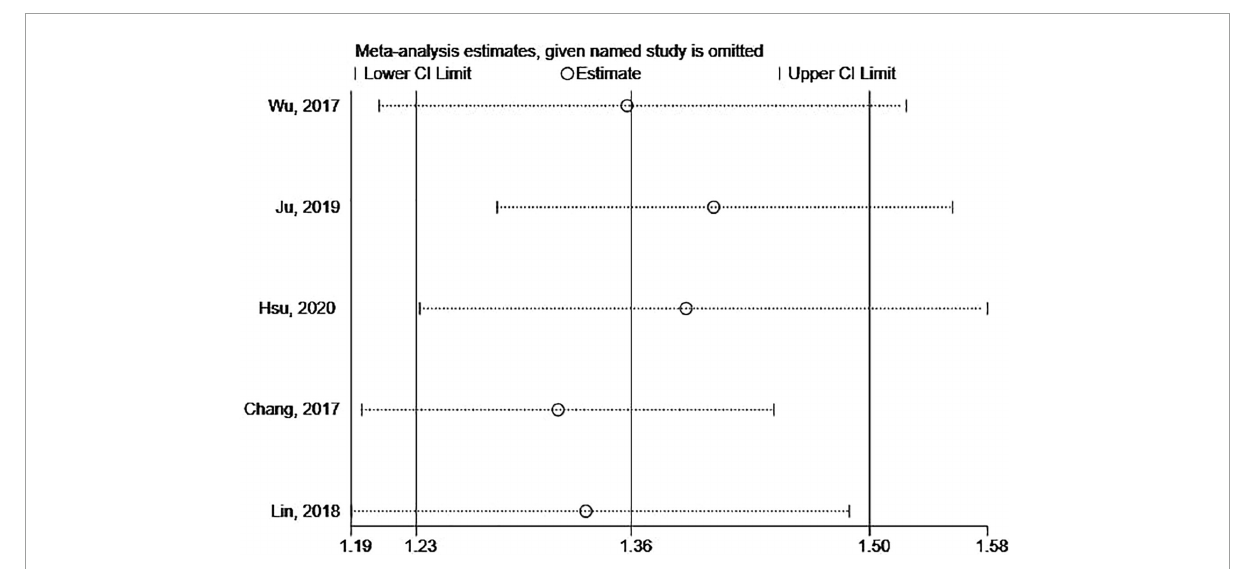
FIGURE7 The sensitivity analysis of the association between SS and risks of PD.